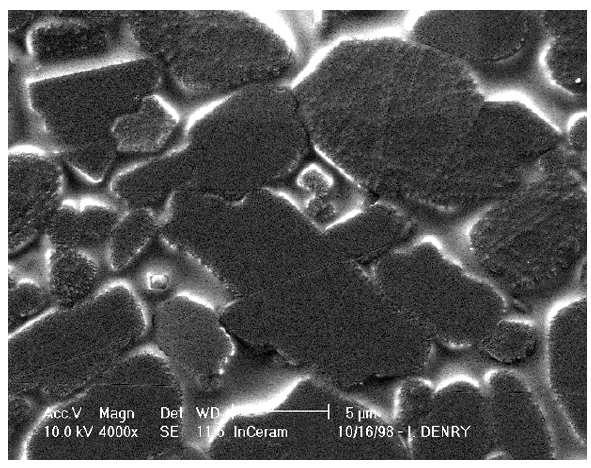
Figure 6. Microstructure of alumina slip-cast